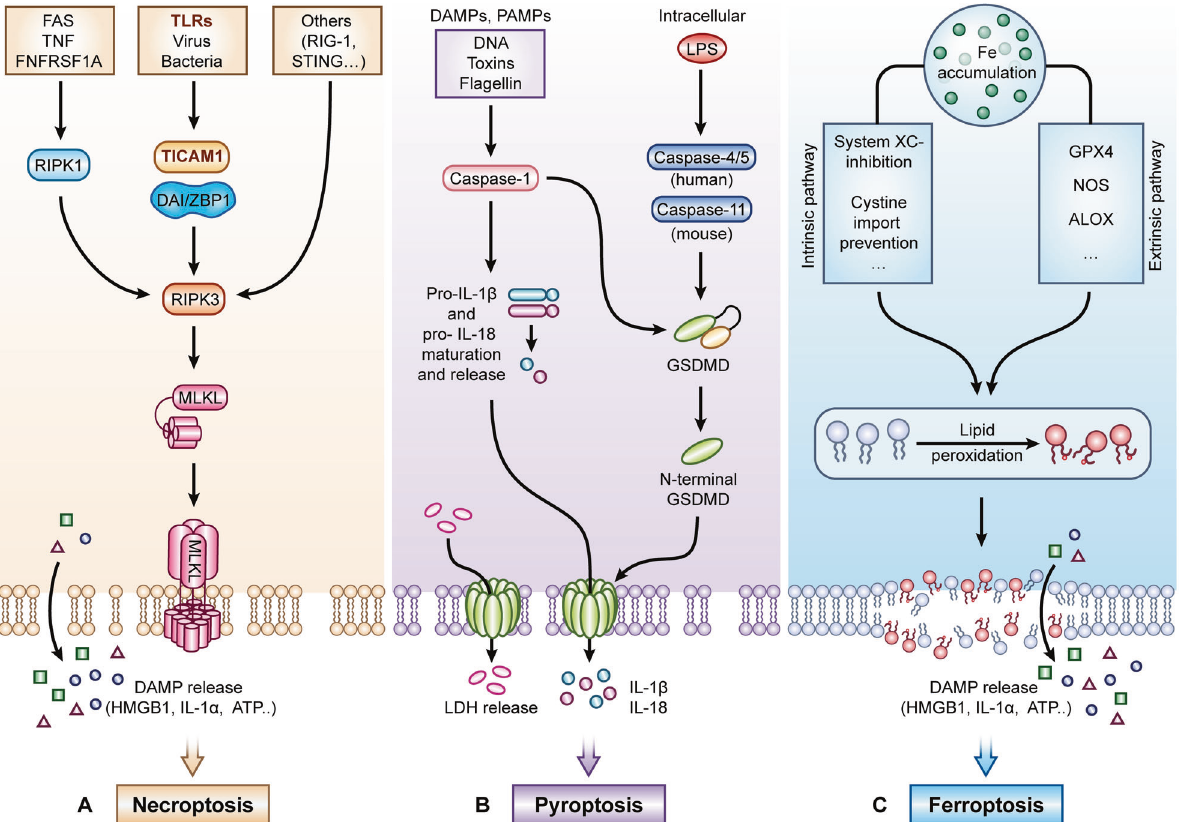
Fig. 1 Molecular pathways of three kinds of regulated necrosis (Necroptosis, Pyroptosis, and Ferroptosis). A MLKL stimulation by RIPK3 is necessary for the execution of necroptosis. The initiators of necroptosis include death receptors (FAS and TNF), TLRs, viruses, bacteria,